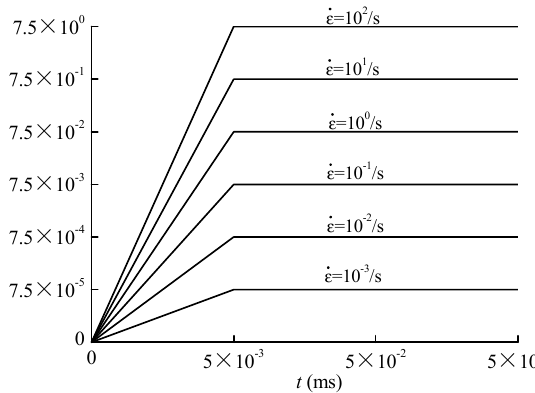
Figure 8. Loading curve of dynamic uniaxial compression test.